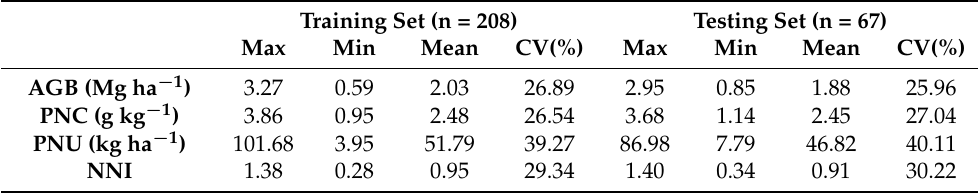
Table 2. Descriptive statistics of aboveground biomass (AGB), plant N concentration (PNC), plant N uptake (PNU), and N nutrition index (NNI) at V7–V8 growth stage for training and testing datasets across drainage, tillage, N treatments, and site